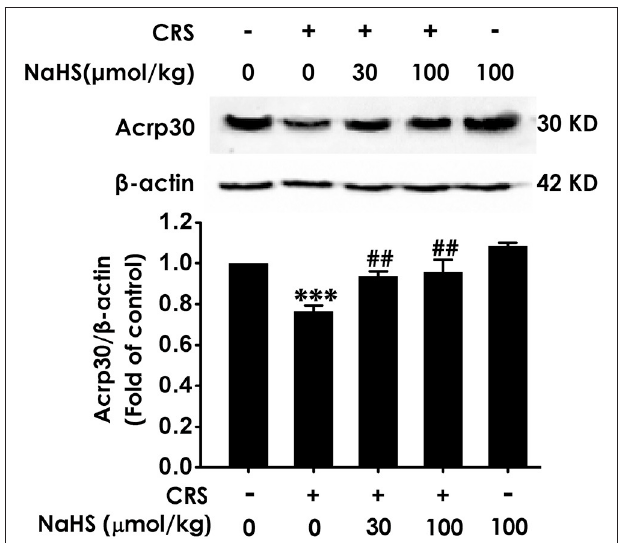
FIGURE 5 | Effect of H 2 S on the expression of Adiponectin in the hippocampus of CRS-treated rats. SD rats were cotreated with CRS and NaHS (30, 100 µ mol/kg, i.p.) for 4w. The expression of hippocampal adiponectin (Acrp 30) was measured by western blotting and β -actin was used as an internal control. Values are expressed as means ± SEM ( n = 3). *** P < 0.001, vs. control group; ## P < 0.01, vs. CRS-treated alone